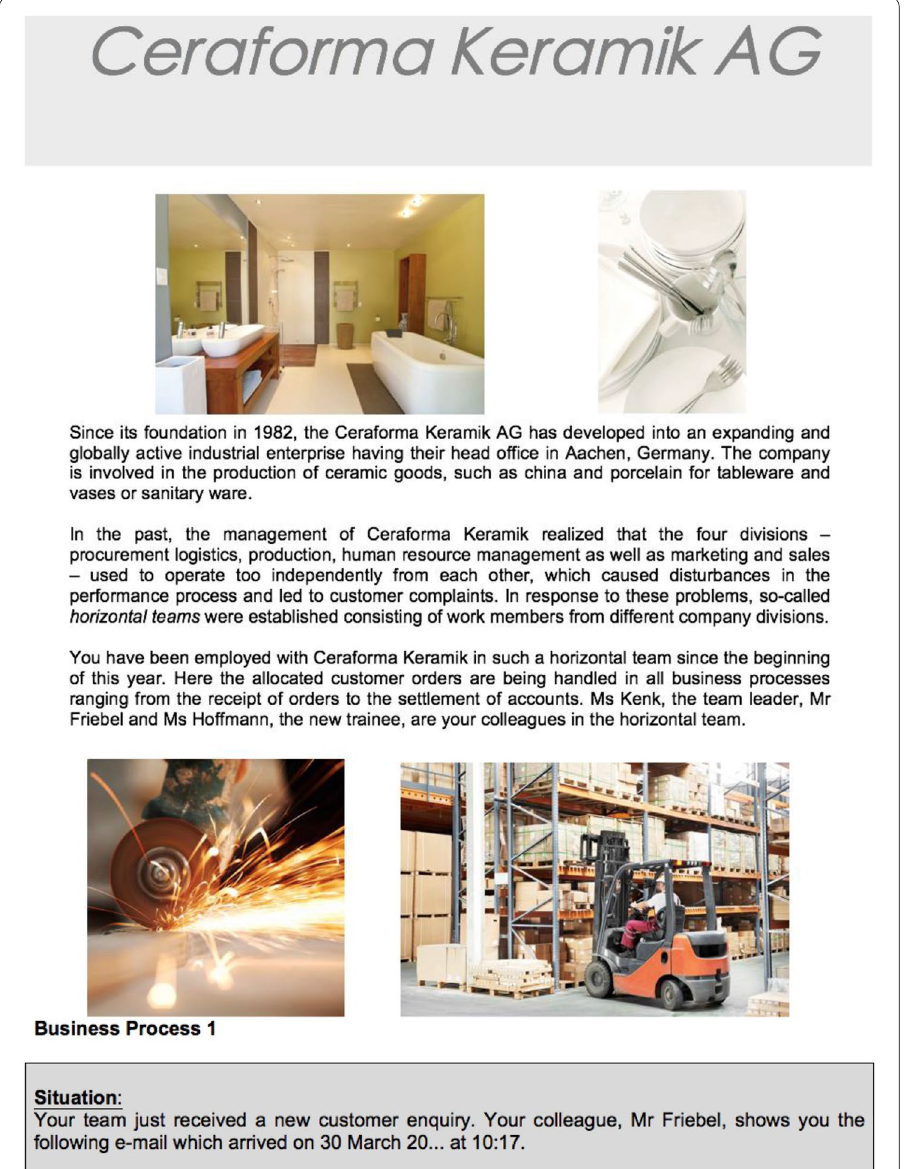
Fig. 5 Exemplary company framework from the competency test (Deutscher and Winther